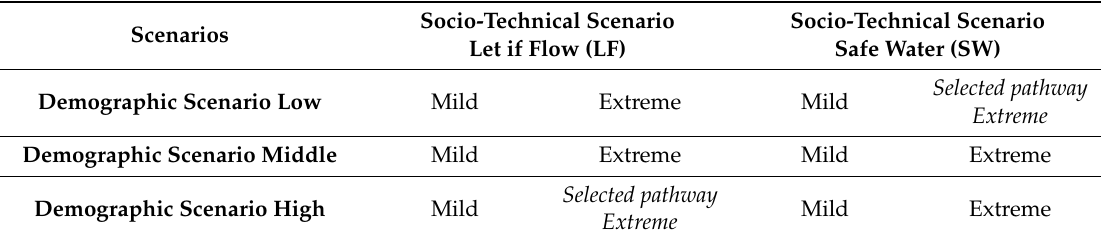
Table 3. Combined scenario outcomes (scenario combinations in italic are the selected